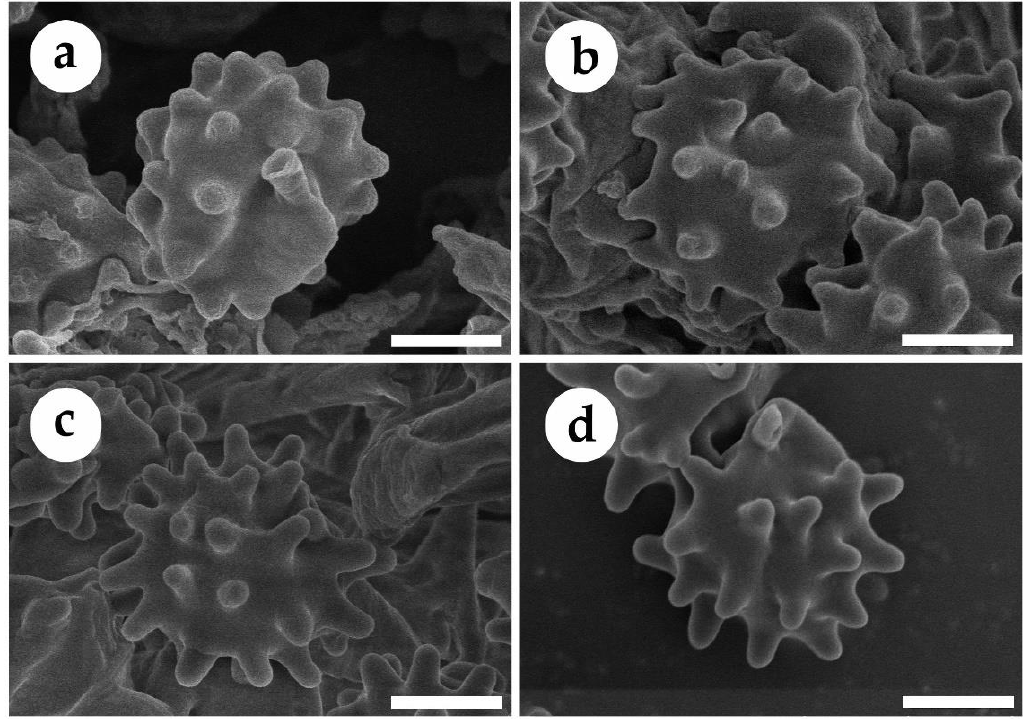
Figure 4. SEM of basidiospores of Phellodon species. ( a ) P. caesius , ( b ) P. concentricus , ( c ) P. henanensis , and ( d ) P. subgriseofuscus . Scale bars: 1.5 µm.